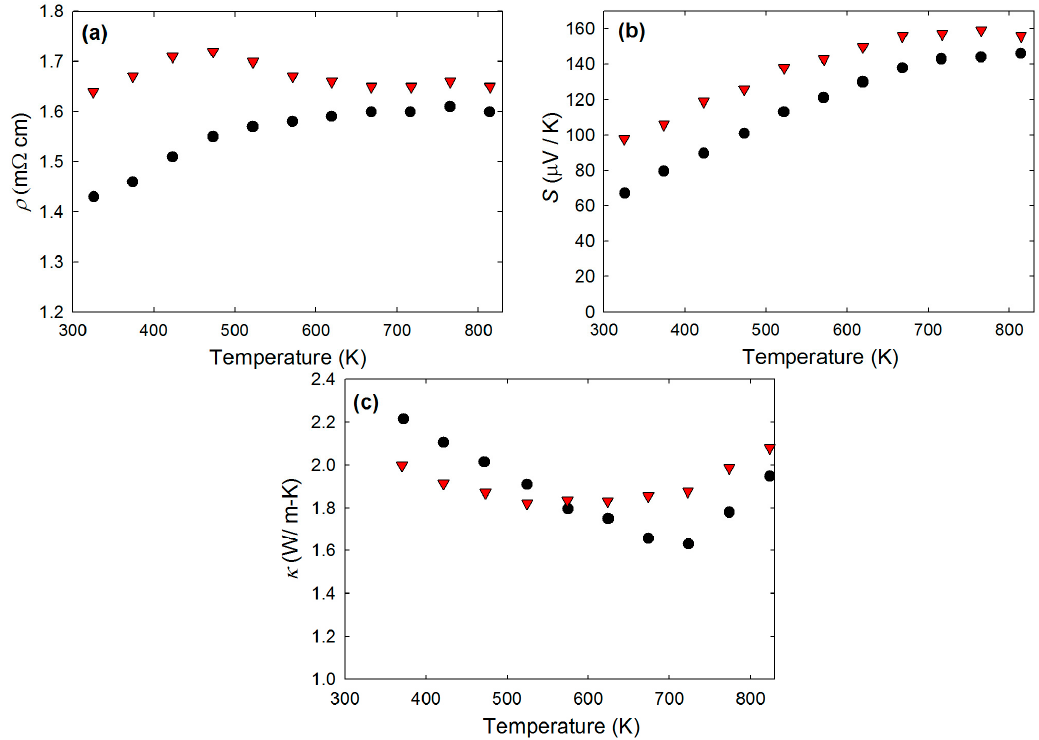
Figure 2. Temperature-dependent ( a ) ρ , ( b ) S , and ( c ) κ for Yb 0.13 In 0.02 Co 3 FeSb 12 (circle) and Yb 0.39 In 0.02 Co 2.4 Fe 1.6 Sb 12 (triangle). Yb 0.39 In 0.02 Co 2.4 Fe 1.6 Sb 12